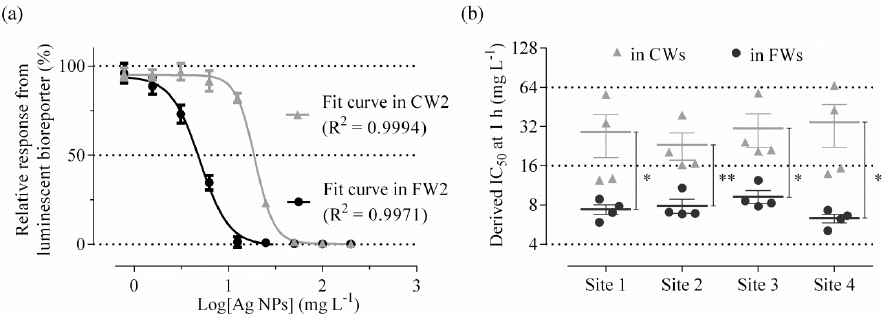
Figure 2. Derived toxicity values. Toxicity results were plotted as (response) = f (log[Ag NPs]) for selected time points and IC 50 values (half maximal inhibitory concentrations) were derived by fitting a four parameter concentration–response model. An example of obtained fits for one test with crude and final wastewaters (CWs and FWs, respectively) from Site 2 (including four replicates per condition) is shown in ( a ). The comparison of all calculated IC 50 values at 1 h is shown in ( b ). Data are mean ˘ SEM ( n = 4), significant differences are represented by with p < 0.1 (*) or p < 0.05 (**) following analysis (Figure